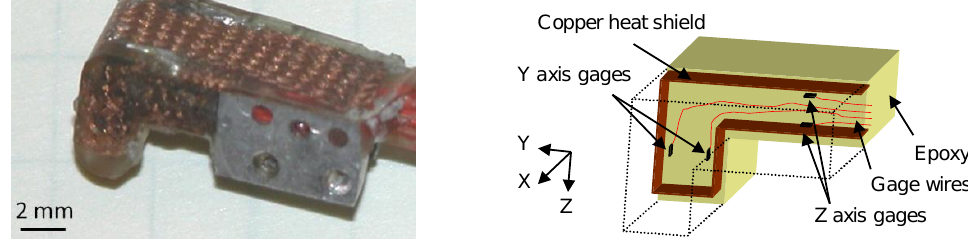
Figure 3. Photograph and cross-sectional diagram of three-axis force sensor. Note copper heat